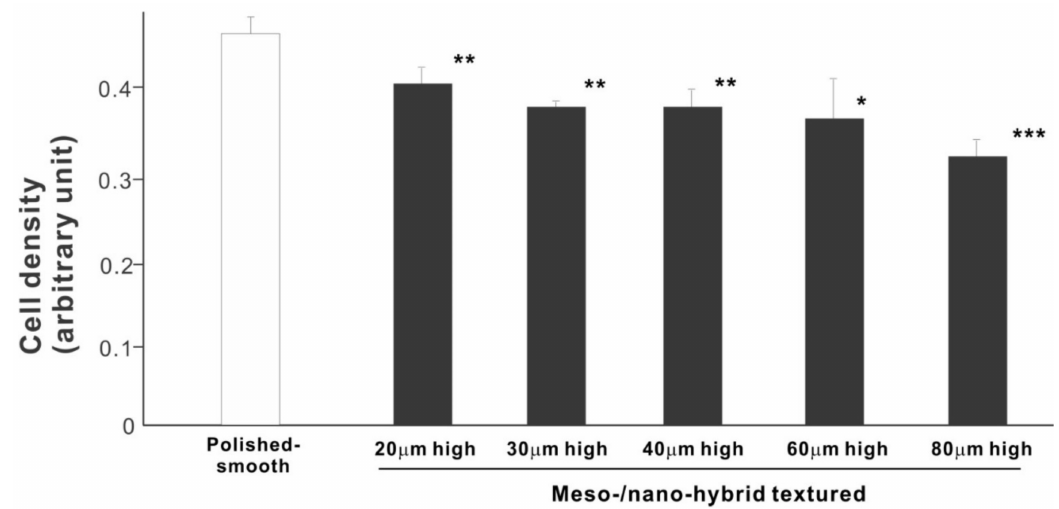
Figure 6. Proliferation of osteoblasts, measured as cell density, on differently textured zirconia surfaces, evaluated by the WST-1 assay on day 5. * p < 0.05, ** p < 0.01, *** p < 0.001, statistically significant difference compared with a polished surface.